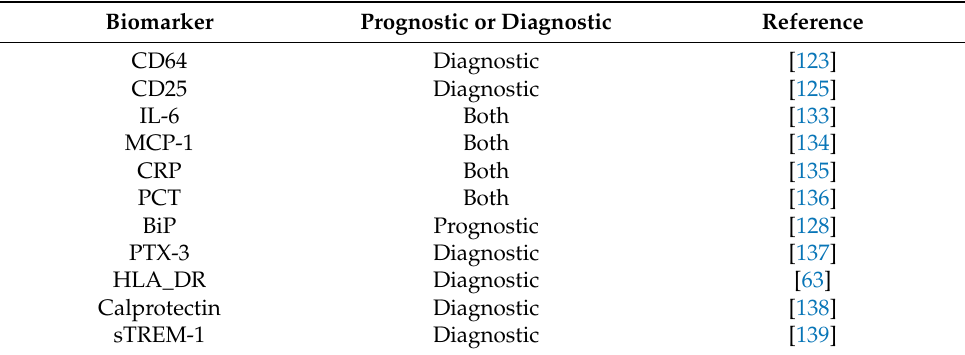
Table 2. Putative diagnostic and/or prognostic biomarkers of